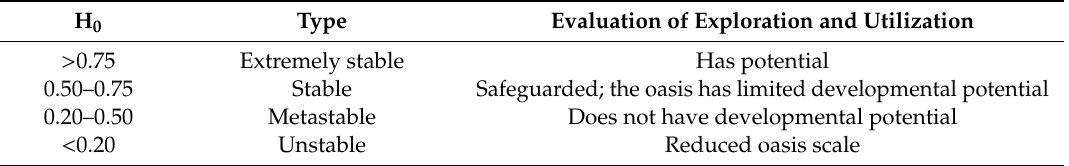
Table 2. Classification of oasis